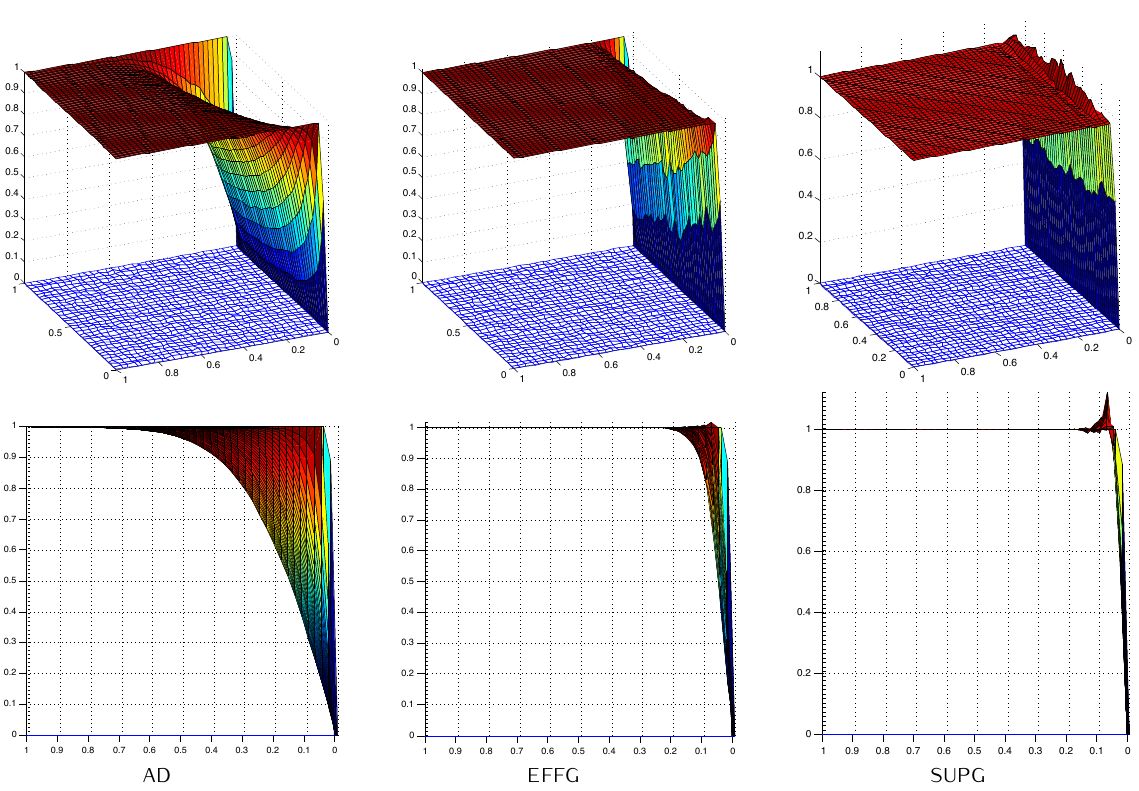
Figure 3. Solution of the horizontal advection test problem (29) with ε = 0 . 00001 by AD (left) vs. EFFG (middle) and SUPG (right) on 33 × 33 randomly perturbed grid. Top row: surface plot. Bottom row: side view.